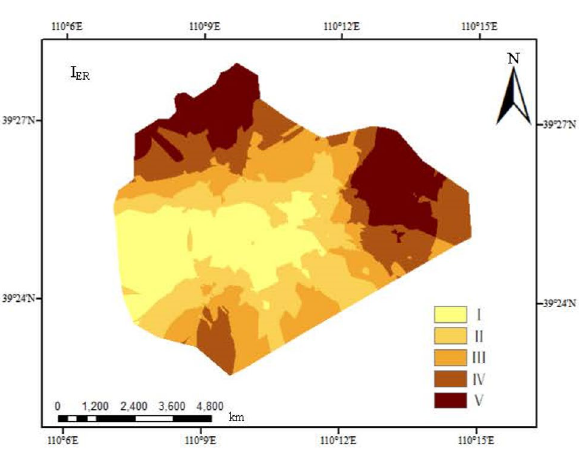
Figure 5. Ecological risk warning assessment of heavy metals in the study area (created by Arcgis 10.8, http:// deskt op. arcgis. com/